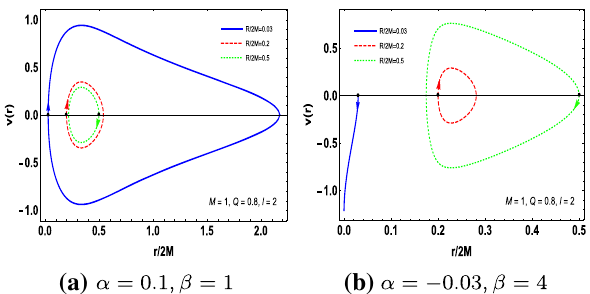
Fig. 3 The velocity v( r ) of an infalling particle for starting at rest at different radii R , where the dot represents the initial position and the arrow represents the direction in which the velocity starts to increase